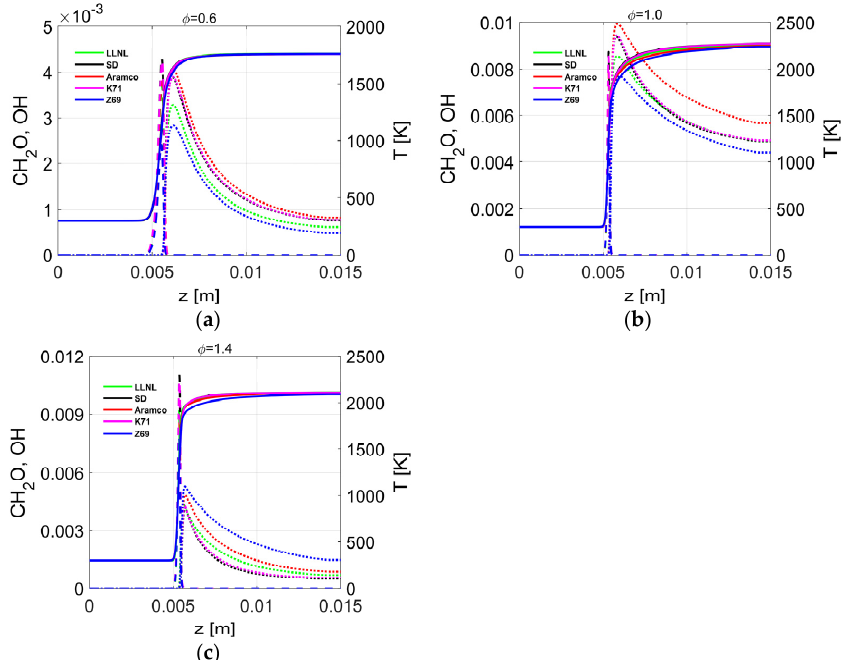
Figure A4. Flame profiles showing the flame temperature (solid line) and minor species concentra- tions, CH 2 O (dashed line) and OH (dotted line), at standard conditions of 1 atm and 300 K. Three equivalence ratios are shown with ϕ = 0.6 in ( a ), ϕ = 1.0 in ( b ) and ϕ = 1.4 in ( c ). Legend: mechanism predictions from Z69 in blue, LLNL in green [28], Aramco in red [17], K71 in magenta [32] and San Diego in black [30].